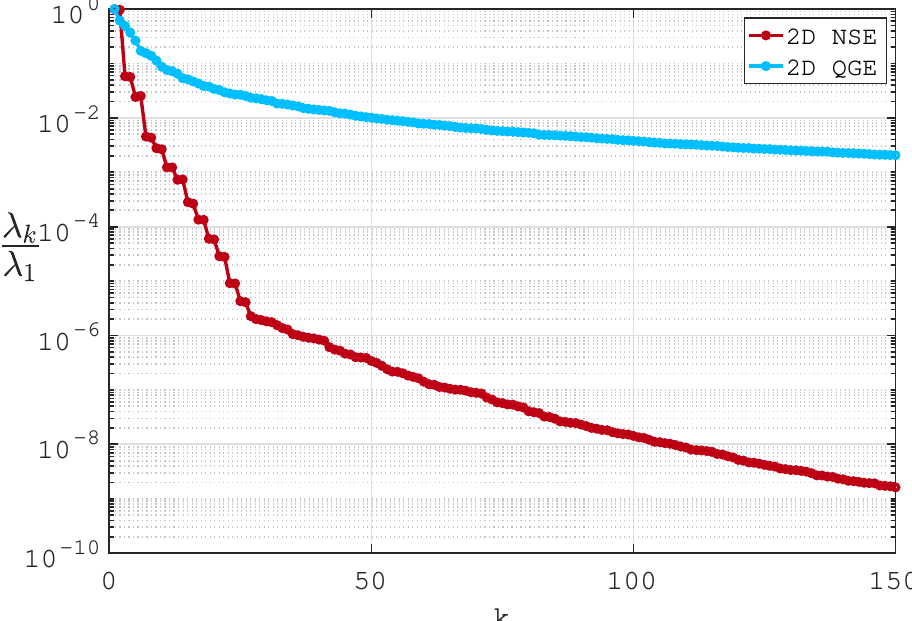
Figure 4. Scaled eigenvalues λ k for the 2D flow past a circular cylinder with Re = 1000 and the QGE λ 1 with Re = 450 and Ro = 0.0036 (see Section 5 for